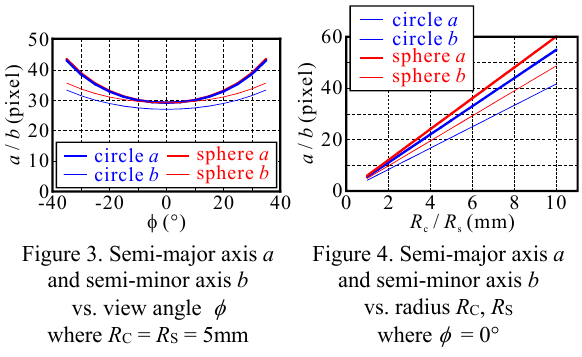
Figure 4. Semi-major axis a and semi-minor axis b vs. radius R C , R S where   = 0°